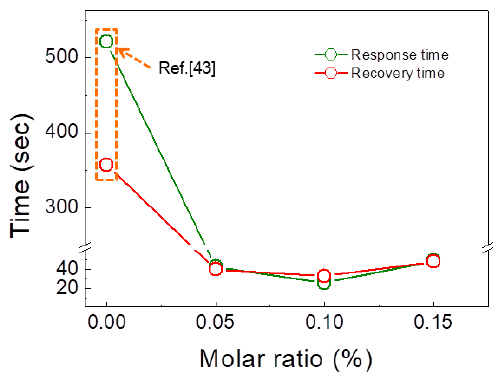
Figure 6. Response and recovery times of xSnO 2 (x = 0, 0.05, 0.1 and 0.15) loaded ZnO NFs to 5 ppm H 2 gas at 300 ◦ H 2 gas at 300 °C.